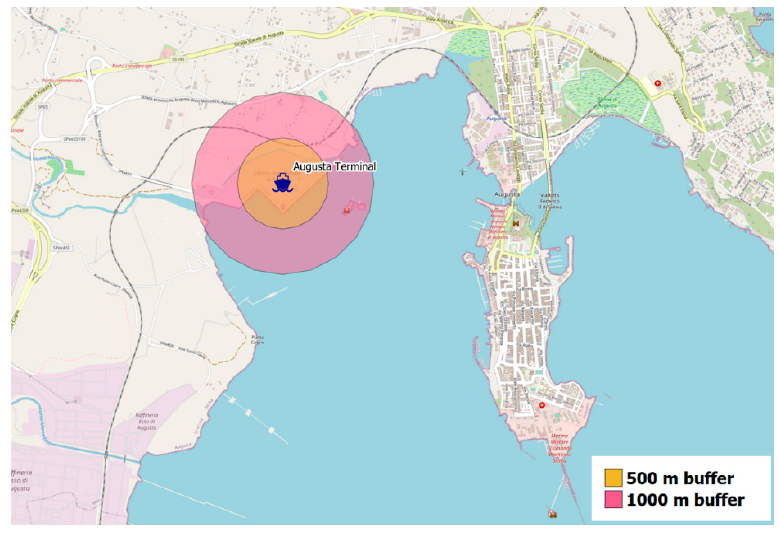
Figure 7. The 500 m and 1000 m buffers from the planned container terminal.